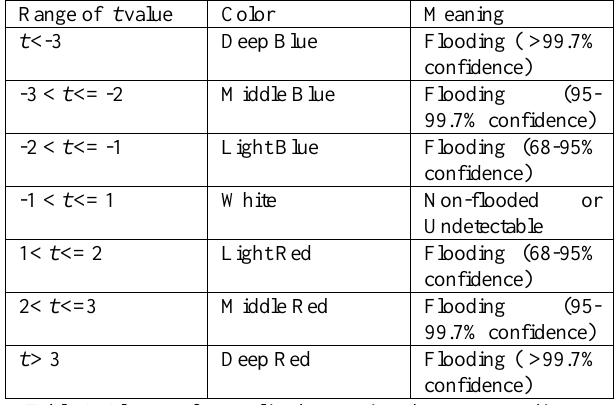
Table 3. Classes of normalized scattering changes according to the color ramp in Figure